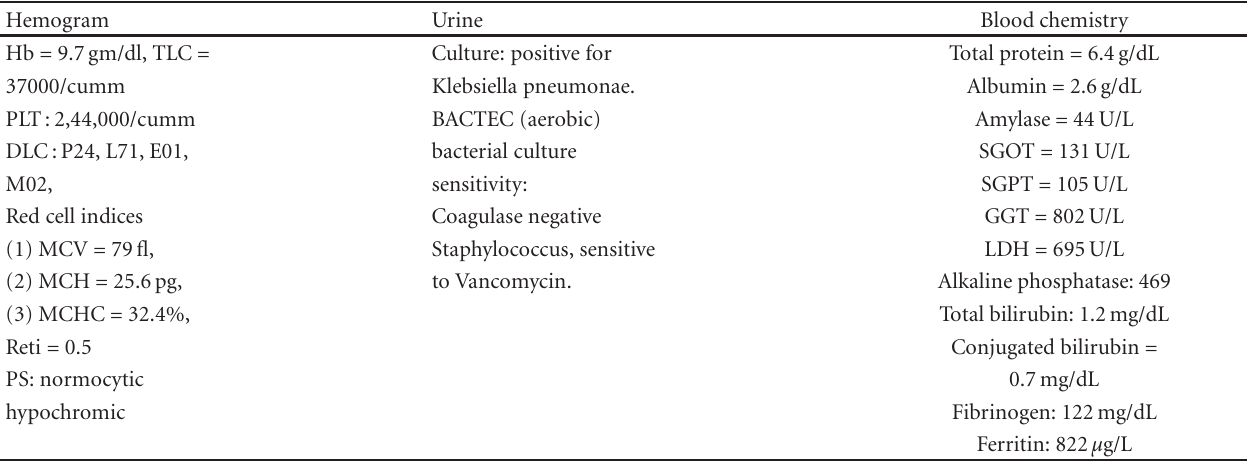
Table 1: Laboratory profile.